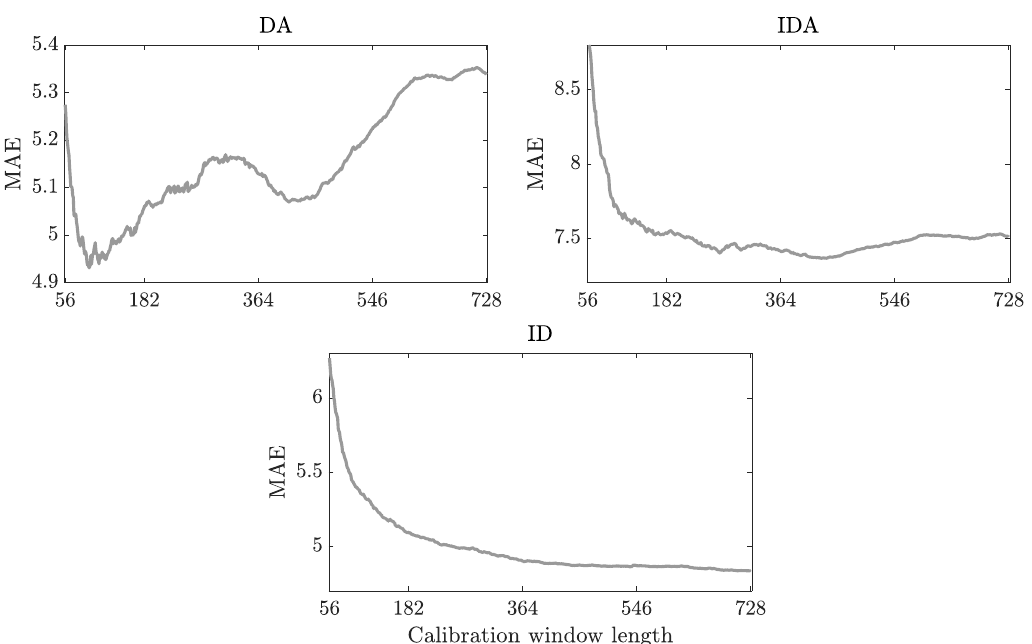
Figure 5. Mean absolute error as the function of the calibration sample length. The results for DA ( top-left ), IDA ( top-right ) and ID ( bottom ) models are evaluated over the whole 778-day out-of-sample test